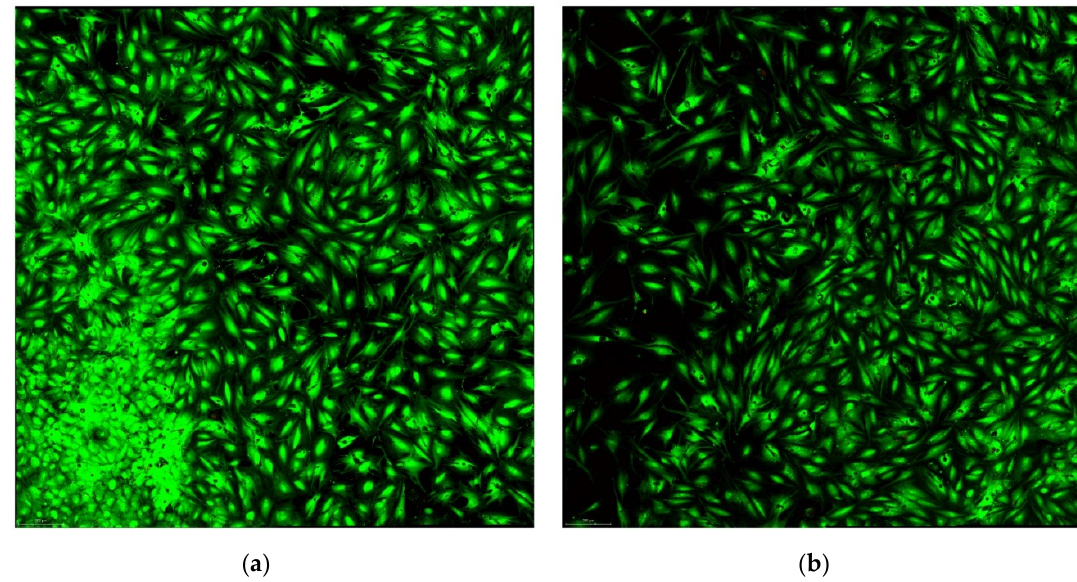
Figure 2. Osteoblast cell viability: ( a ) laser “+” and ( b ) laser “-”. When counting the cells, performed using the Analyze Particles function, in the